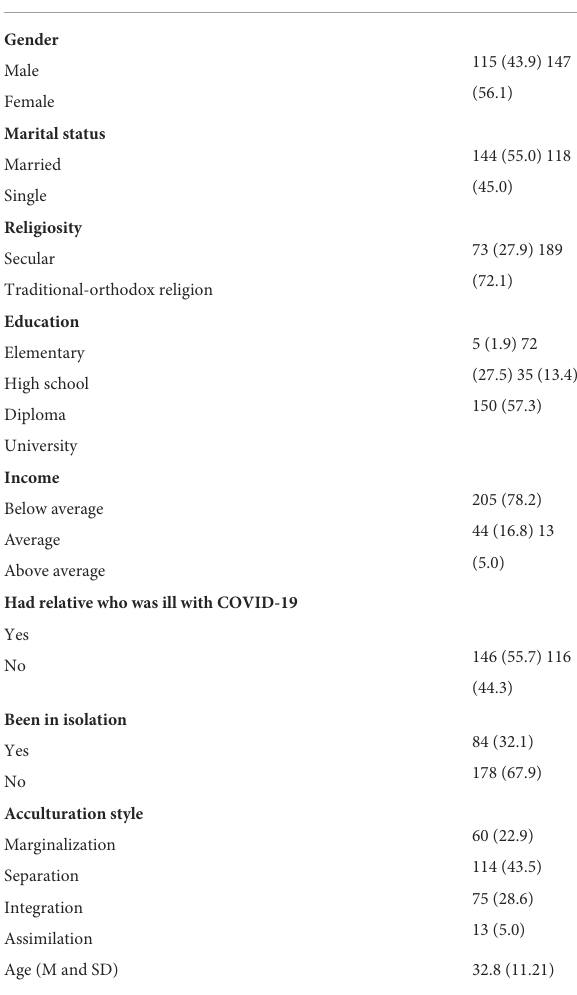
TABLE 1 Sample characteristics ( n =